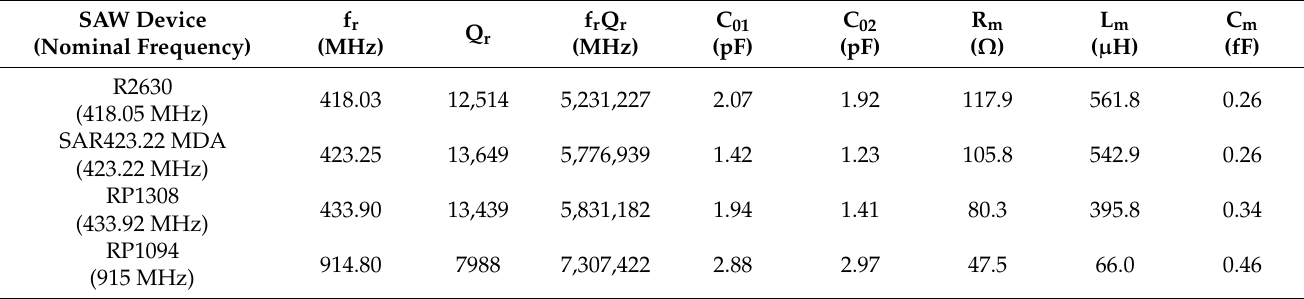
Table 1. Values of the resonant frequency, quality factor, their product, and equivalent-circuit elements for the four studied SAW resonators.